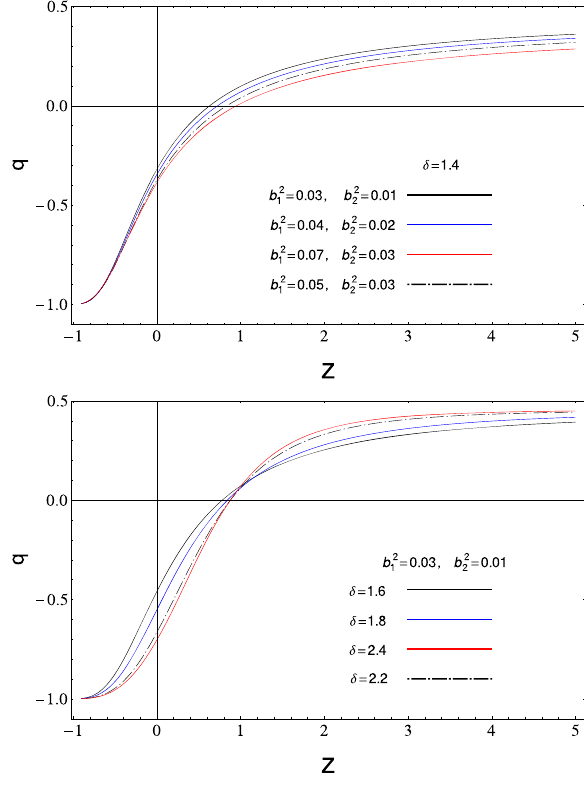
Fig. 2 Evolution of ω D as a function of z is shown using (cid:5) 0 and different values of b 2 , b 2 and δ , as indicated in each panel 1 2 been obtained from the latest compilation of 41 data points of Hubble parameter measurements (for details, see [91,92]).